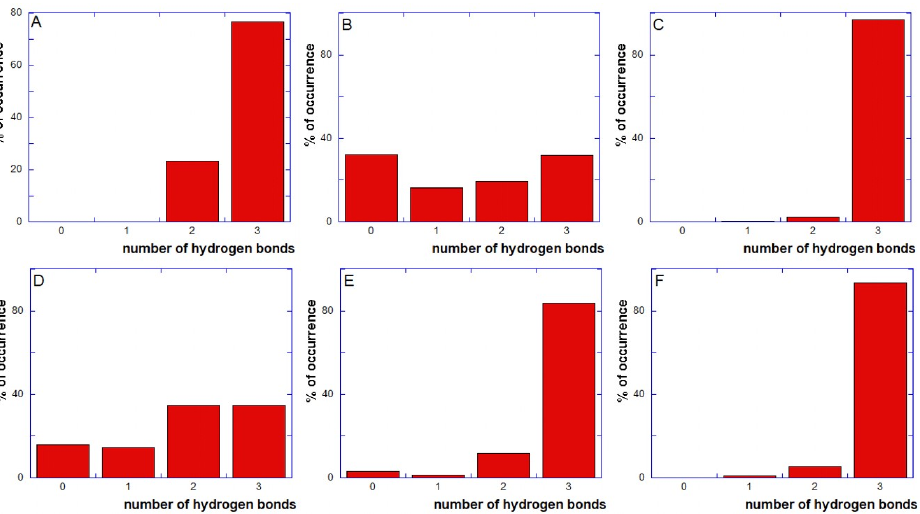
Figure 4. Percentage of occurrence of one, two, or three hydrogen bonds with the complementary base of ( A ): GTP; ( B ): PENT; ( C ): G24; ( D ): PEN24; ( E ): G23; and ( F ): PEN23. Standard deviation is below 5%.